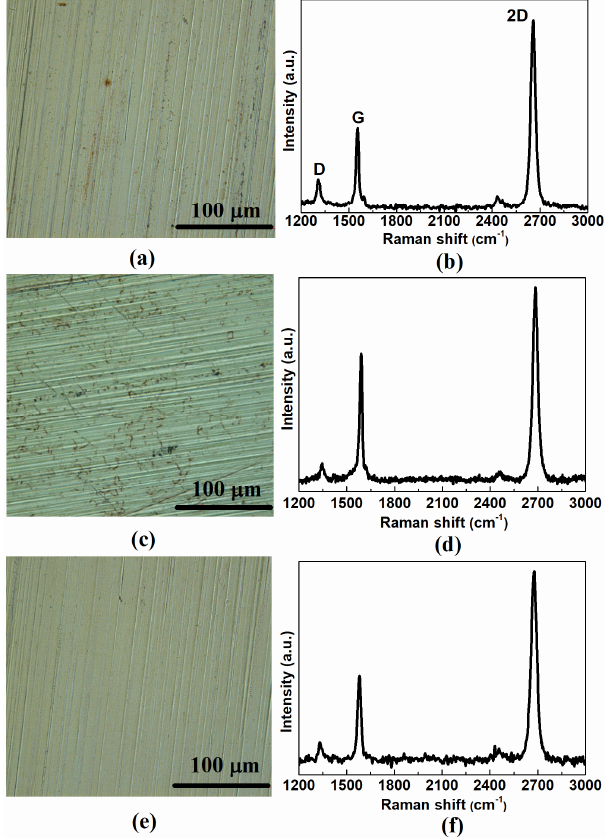
Figure 1. The optical images of the original ( a ), hydrochloric acid- ( c ), and ethylic acid-treated ( e ) copper foil. The Raman spectrum of the boron-doped graphene films synthesized on the original ( b ), hydrochloric acid- ( d ), and ethylic acid-treated ( f ) copper foil.